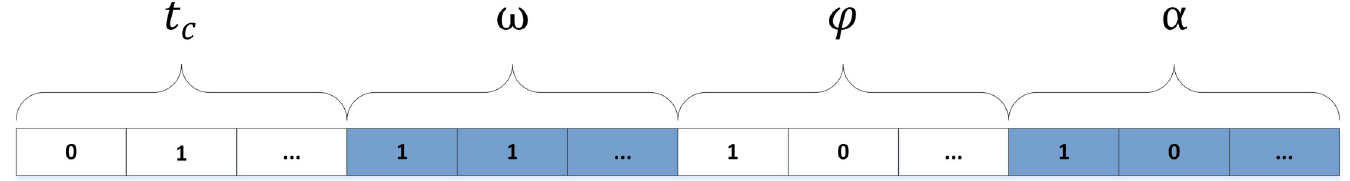
Fig 1. Representation for an